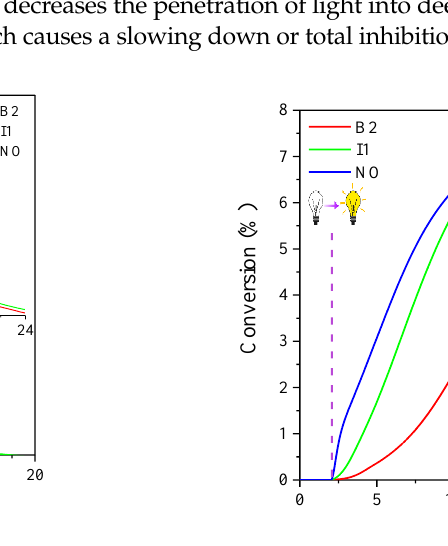
Figure 19. Kinetic profiles recorded during radical polymerization of trimethylolpropane triacrylate (TMPTA) initiated by two-component photoinitiating system consisted of PSQ1 (or PSQ2—inset) as sensitizer in the presence of various co-initiators, marked on the figure. The experimental conditions: concentration of PI—1 × 10 − 3 M; light intensity—50 mW × cm − 2 . Reproduced from ref. [114], with permission from The Royal Society of Chemistry, 2022.